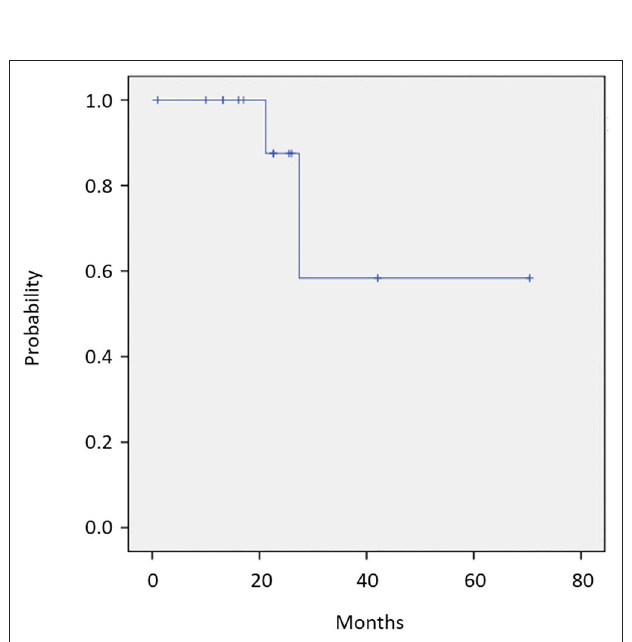
FIGURE 3 | Progression-free survival ( N = 14). Median PFS was 4.1 months (95% CI, 2.6–5.6 months).